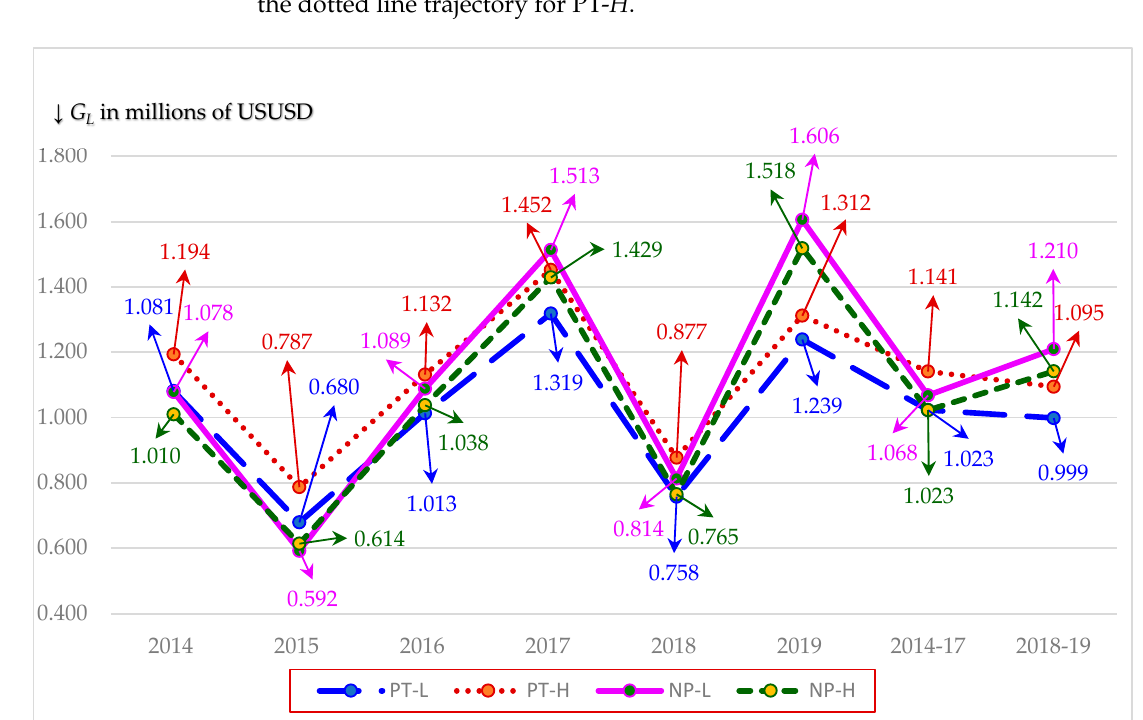
Figure 6. Maximum gain to leverage ( max G L ) values are plotted along the vertical axis against six years (where annual credit spreads are different) and two periods (where annual credit spreads are averaged) along the horizontal axis. The four trajectories are NP- L trajectory, solid line; NP- H trajectory, small dashed line; PT- L trajectory, large dashed line; and, PT- H trajectory, dotted line. We use pre-TCJA tax rates for 2014–2017 with 3.12% growth rate and TCJA tax rates for 2018–2019 with 3.90% growth rate. Both the low ( L ) and high ( H ) tax rates are used where the growth ( RE ) constraint sets in after Ba1 for nonprofits (NPs) and after Ba2 for pass-throughs (PTs). As seen in Table 6, the optimal credit rating ( OCR ) varies over time with an OCR of A3 for the last two years of 2018 and 2019 for both NPs and PTs.